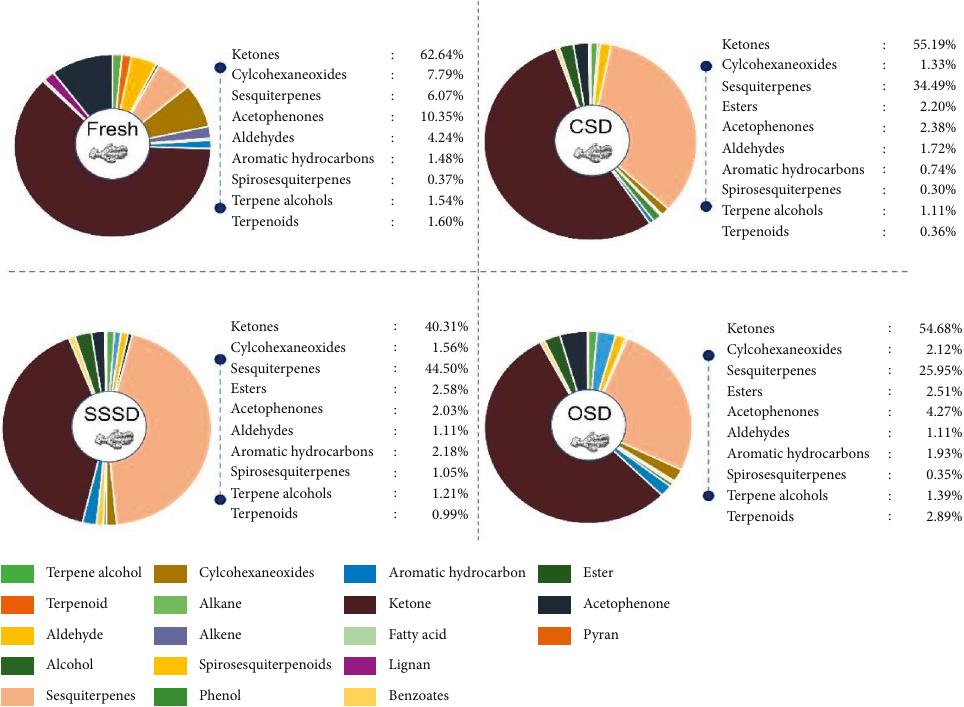
Figure 3: Categorization of the Pungent and flavor compounds from the fresh and dried ginger